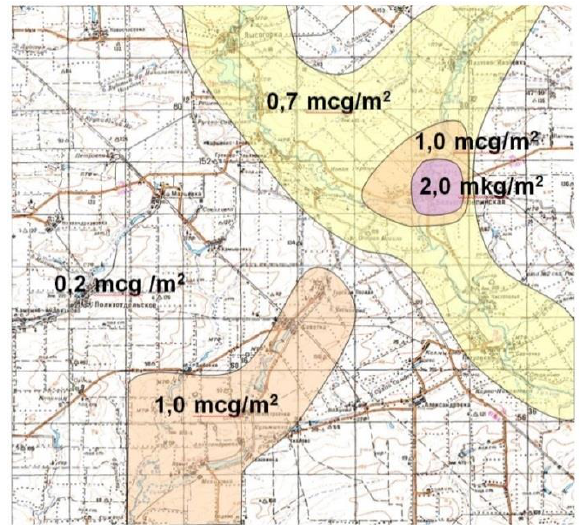
Fig. 7. A part of the map with chemical polluted areas.